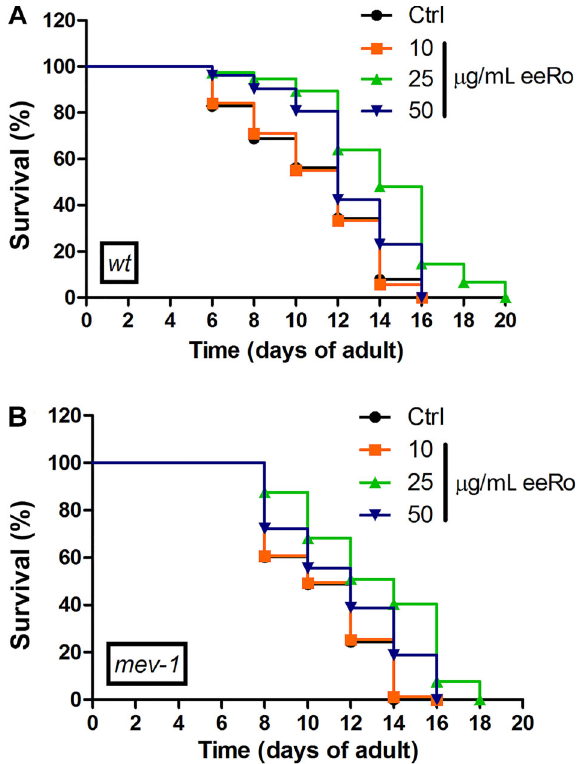
Figure 4 . Effect of ethanolic extract of Rosmarinus of fi cinalis L. (eeRo) on C. elegans lifespan. Survival curves were signi fi cantly extended in ( A ) wild-type and ( B ) mev-1 worms treated with 25 m g/mL eeRo (P o 0.0001, log-rank (Mantel-Cox)